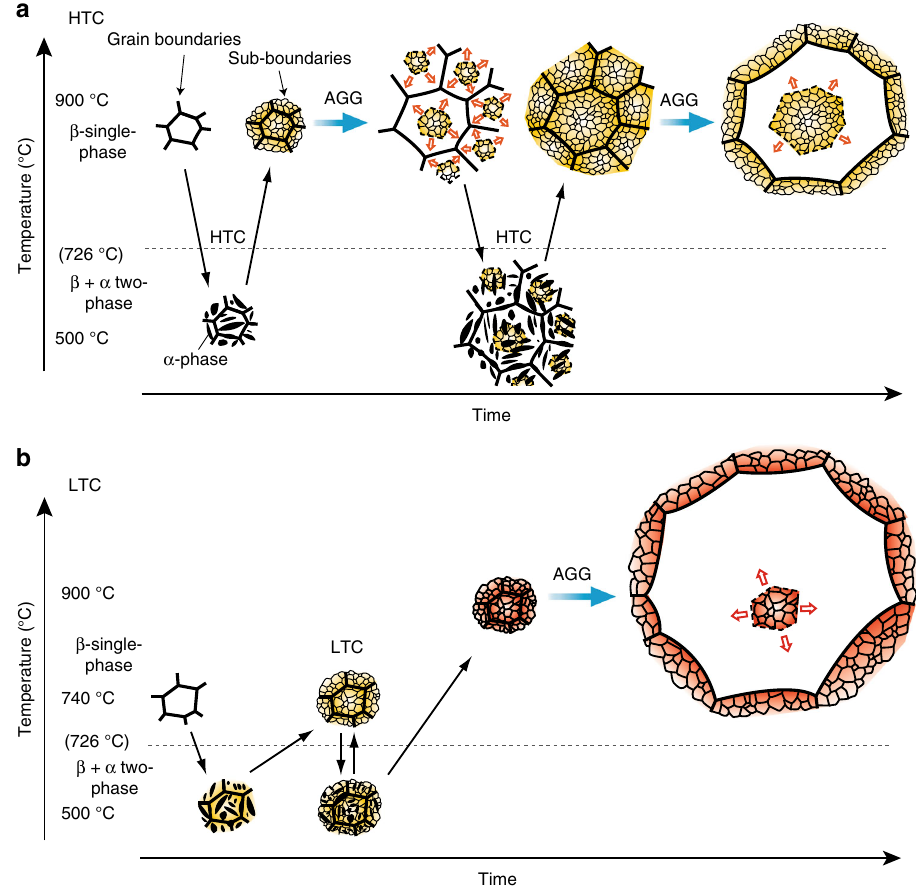
Fig. 3 Schematic illustrations of abnormal grain growth (AGG) phenomenon. a In high-temperature cycles (HTC) (900/500 °C), the subgrain structure formed in association with α -phase precipitation at 500 °C remains after resolution of α -phase in heating. At 900°C after HTC, some grains start AGG by consuming the surrounding subgrains, and this continues until the abnormal grain (AG) comes in contact with a neighboring AG, where the dominant driving pressure for grain boundary (GB) migration is the sub-boundary energy. AGG can repeatedly occur if HTC is repeated. b In multiple low-temperature cycles (LTCs) (740/500 °C), the sub-boundary energy increases due to the increasing misorientation between subgrains. As a result, the GB migration rate at 900 °C becomes faster and a super-large crystal can be